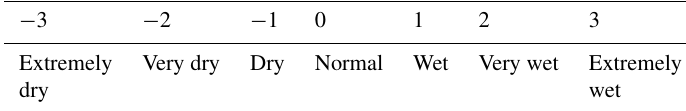
Table 1. Seven-degree precipitation index (Pfister, 1999; Brázdil et al., 2013; Glaser, 2013). − 3 − 2 − 1 0 1 2 3 Extremely Very dry Dry Normal Wet Very wet Extremely dry